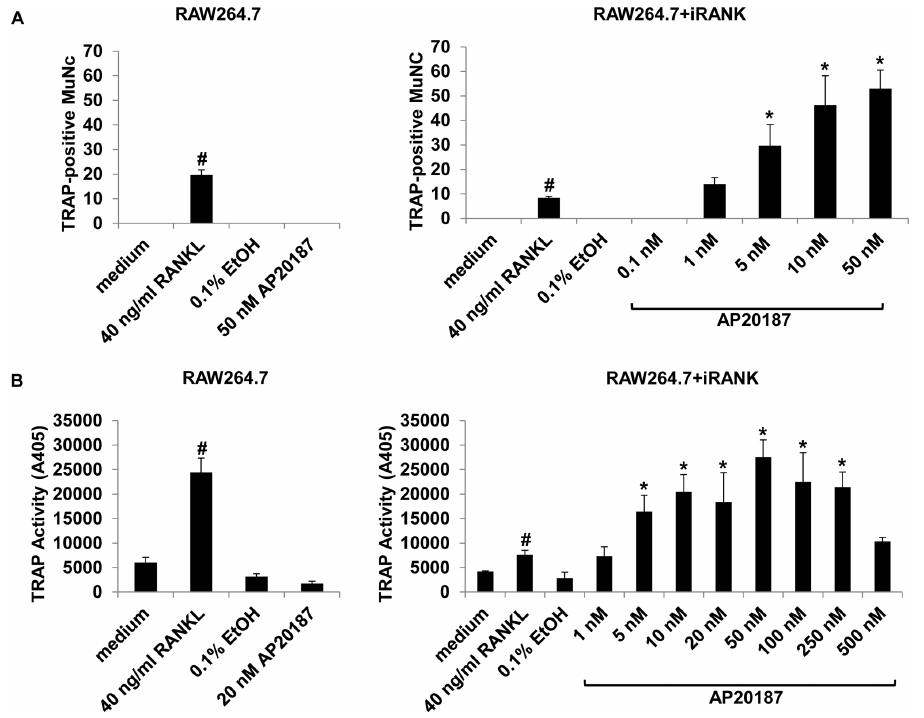
Figure 3. Dose-dependency of AP20187. (A) RAW264.7 and RAW264.7 + iRANK cells were cultured in medium alone, or medium containing vehicle (EtOH), RANKL, or 0.1–50 nM AP20187 for 4 days and the cells were stained for TRAP. The number of TRAP-positive multinucleated cells (MuNC) was determined per 4 high power fields of view and averaged over 3 wells. Cells containing more than three nuclei were counted as multinucleated cells. (B) Dose-dependent induction of TRAP activity following RANKL or AP20187 treatment. Left panel: RAW264.7 cells. Right panel: RAW264.7 + iRANK cells. The TRAP-activity in RAW264.7 + iRANK cells reached a maximum at the 50 nM AP20187 treatment. # p , 0.05 compared to medium, *p , 0.05 compared to 0.1% ETOH. doi:10.1371/journal.pone.0084465.g003 with RAW264.7 + iRANK cells, and all of these stained positively for TRAP (Figure 7B), whereas no multinucleated TRAP-positive cells were seen in scaffolds seeded with RAW264.7 cells (data not shown).